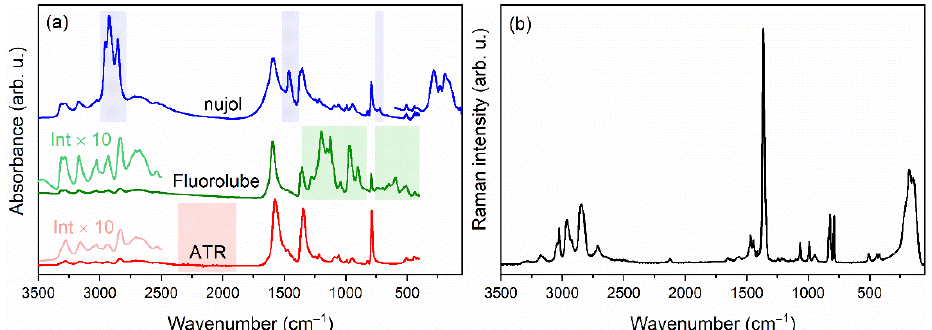
Figure 2. RT polycrystalline IR ( a ) and Raman ( b ) spectra of [DMHy]Mn(HCOO) 3 . The shaded fields correspond to regions where absorption bands of dielectric media (nujol, Fluorolube) or ATR crystal occur, and therefore, they are not analysed. Table 1. The tentative assignments of IR and Raman bands observed for polycrystalline [DMHy]Mn(HCOO) 3 . Raman IR